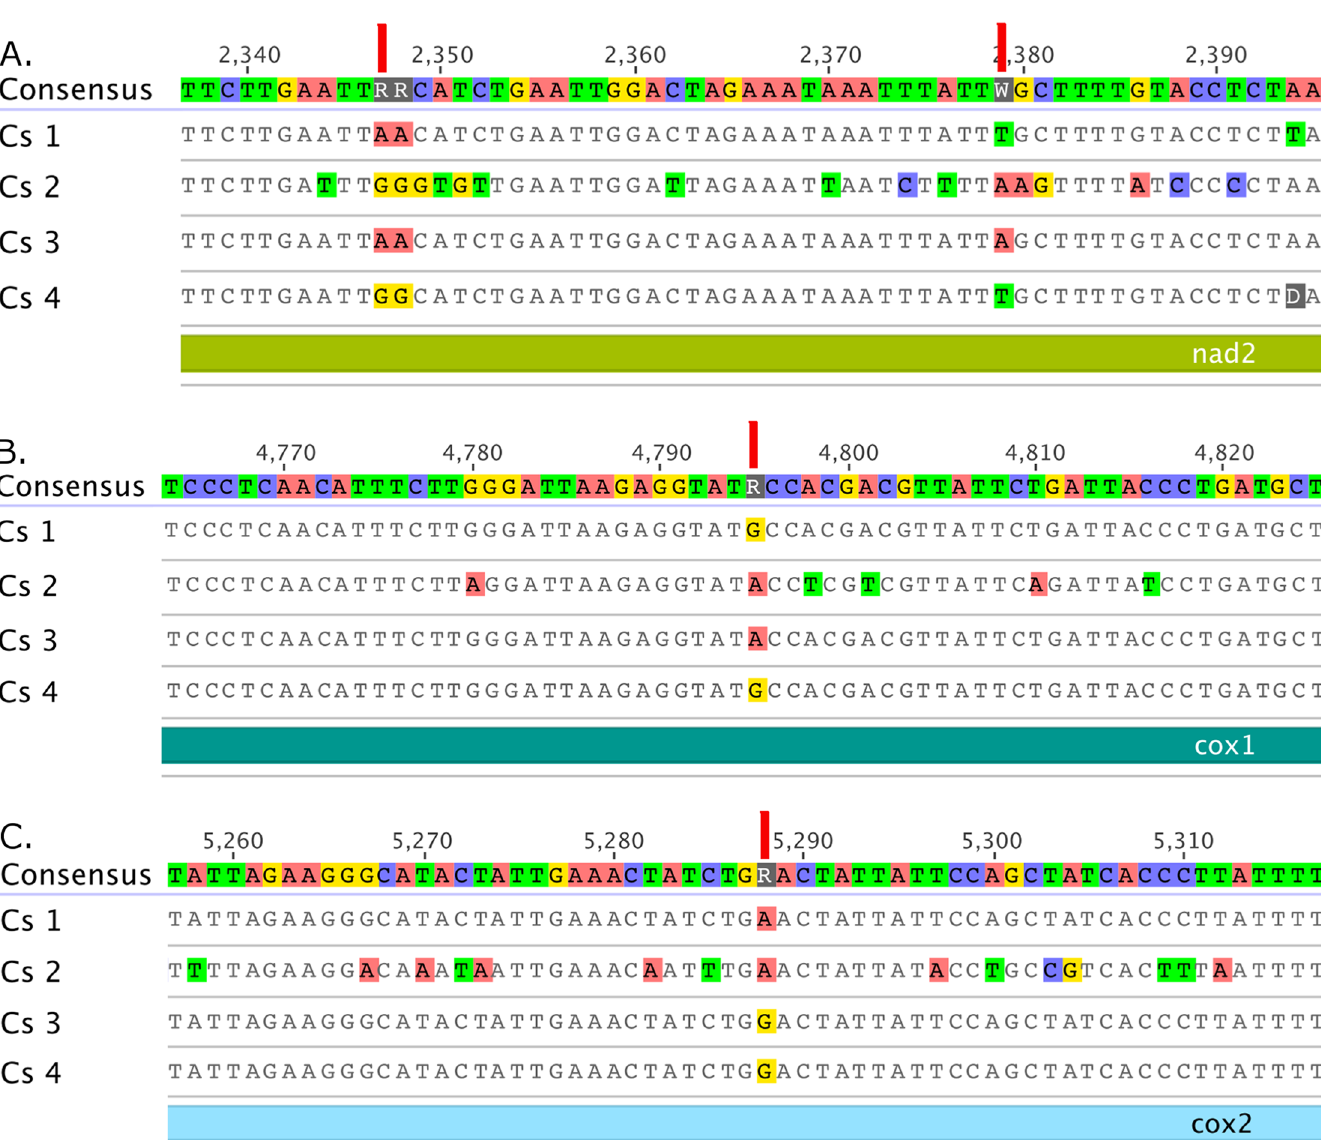
Fig 4. Examples of dissimilarities observed in the mitogenomes of C . sanguinea (Cs) generatedby different pipelines. The alignments are parts of (A) nad 2, (B) cox 1 and (C) cox 2 genes, with the consensus sequenceon the top and the four methods below (Cs1, Cs2, Cs3, and Cs4).